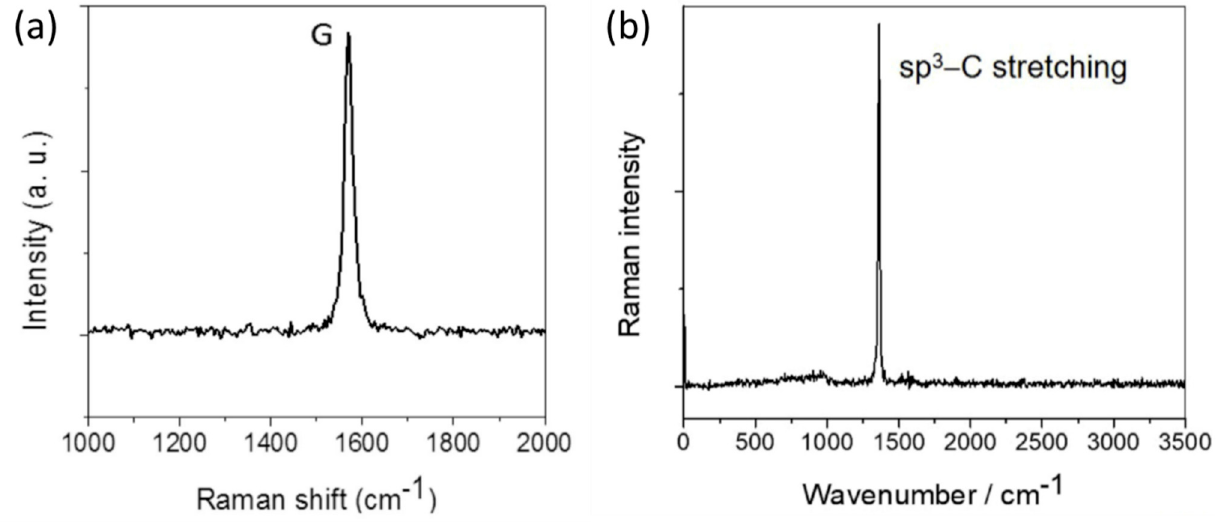
Figure 12. UV Raman spectra (at 244 nm) of few-layer graphene before ( a ) [37] and after hydrogenation ( b ) [38].